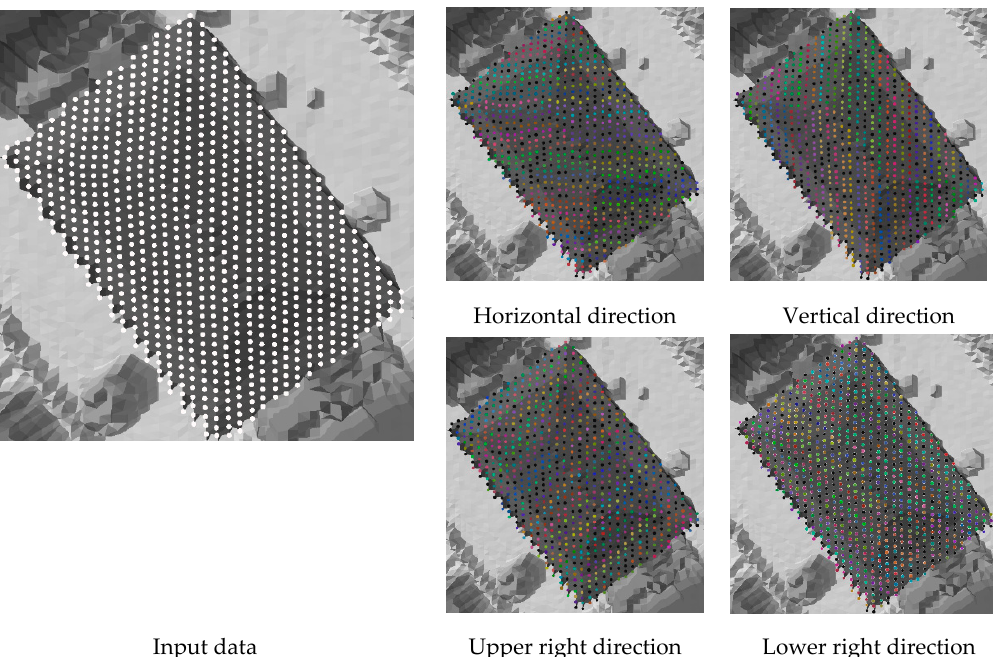
Figure 2. Line segmentation in four directions.